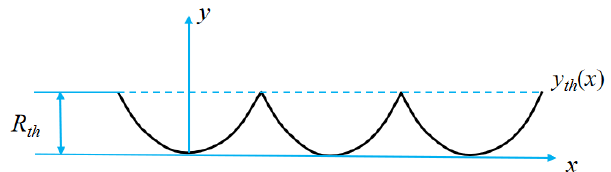
Figure 4. Surface profile of workpiece in theoretical conditions.